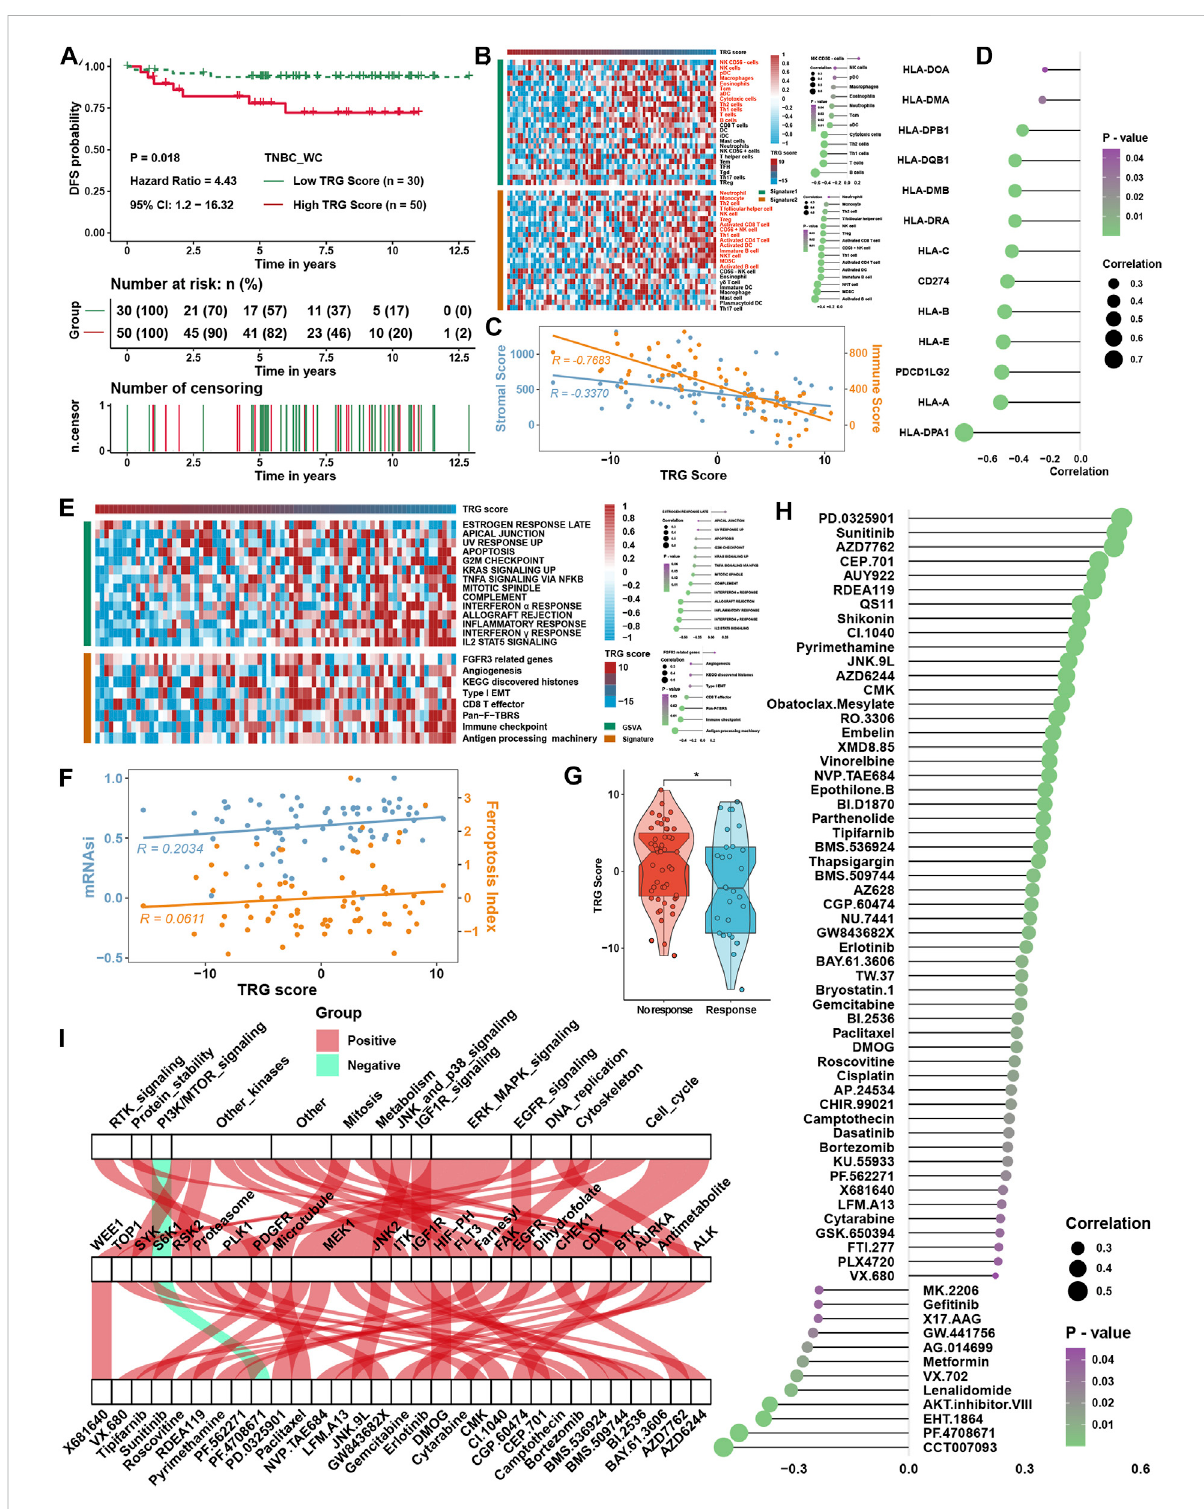
FIGURE 8 Veri fi cation of TRG score in TNBC_WC cohort. (A) Survival analysis for the TRG score. (B) Heatmap of immune cell in fi ltration levels calculated with immune cell signatures 1 and 2. (C) Correlation analysis between the TRG score and ESTIMATE score, including the stromal score and immune score. (D) Correlation analysis between the TRG score and the expression of MHC molecules. (E) Correlation analysis between the TRG score and curated pathway enrichment score. (F) Correlation analysis between TRG score and FPI and mRNAsi. (G) Differences in TRG score between immunotherapyrespondentsandnonrespondersinTIDE analysis. (H) Correlationanalysis betweentheTRGscore andpredicted IC50 values. (I) The intersection of GDSC drugs with signi fi cance between the results of four TNBC cohorts and the TNBC_WC cohort. The asterisks represent the statistical p value (* p <